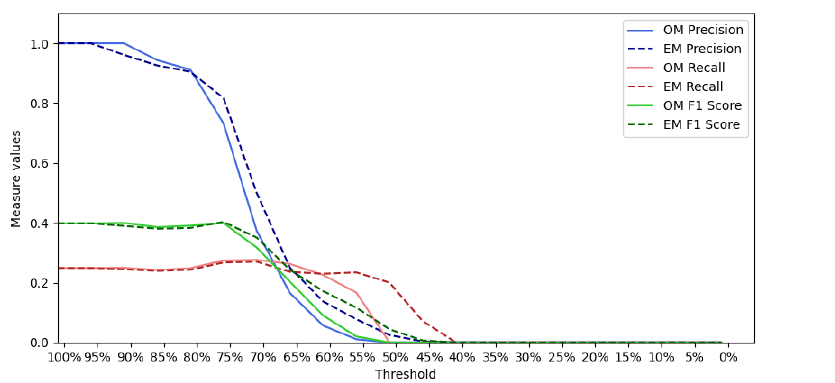
Figure 17. Results of the event “Germanwings”.